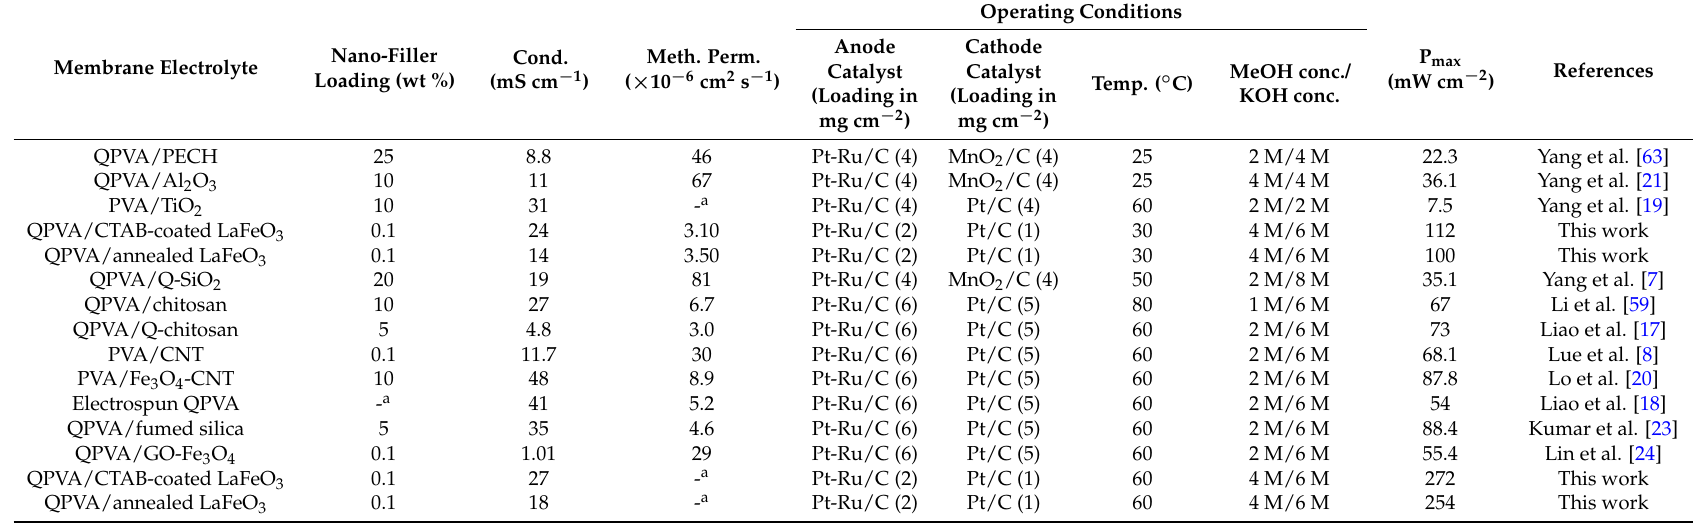
Table 2. Comparison of maximum power densities for direct alkaline methanol fuel cells using various membrane electrolytes with conductivity and methanol permeability values. (Fuel cell catalyst loadings and temperatures are shown for